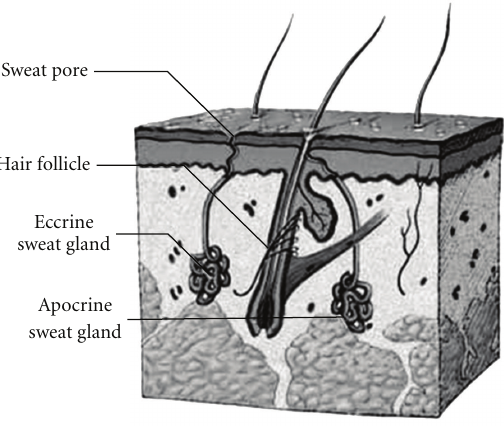
Figure 2: Anatomy of sweat